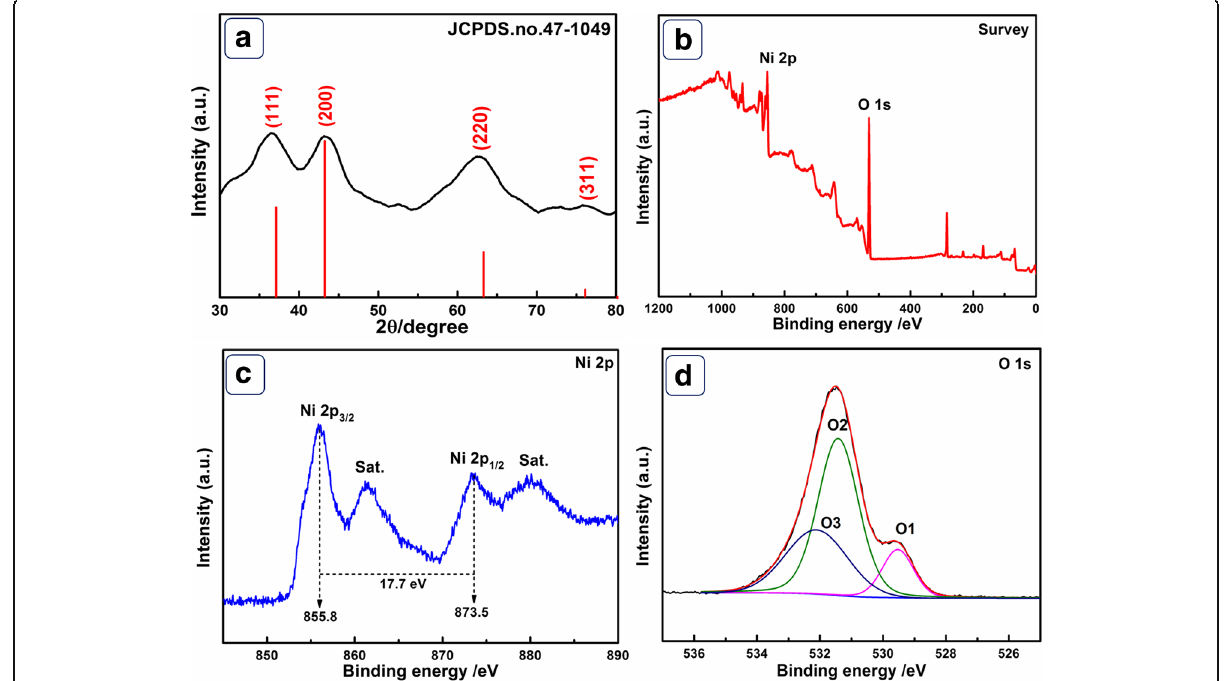
Fig. 1 a XRD pattern of prepared NiO HPA. XPS spectra for the products b survey, c Ni 2p, and d O